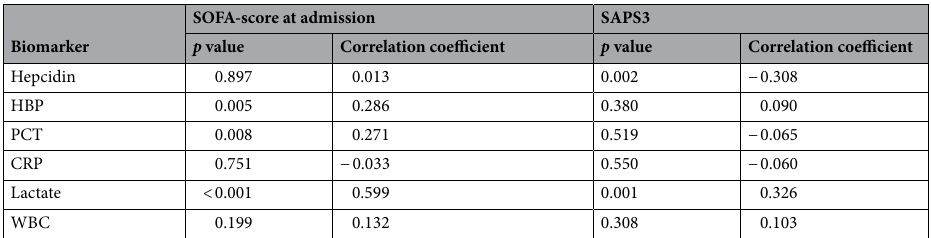
Table 5. Sequential Organ Failure Assessment (SOFA)-score and Simplified acute physiology score III (SAPS3) at admission analysed through Spearman’s rank correlation coefficient in the sepsis/septic shock group. Hepcidin , heparin-binding protein (HBP), procalcitonin (PCT), C-reactive protein (CRP), lactate and white blood cells (WBC).